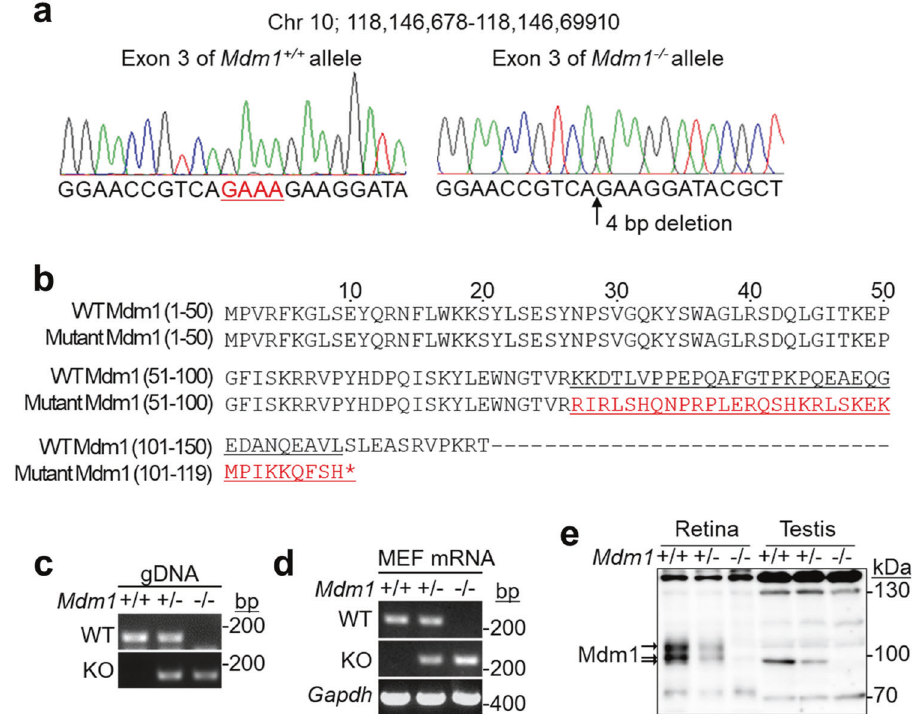
Fig. 1 Generation of Mdm1 − / − mice using a CRISPR/Cas9 system. a The DNA sequences of Mdm1 + / + and Mdm1 − / − alleles in Mdm1 exon 3. The deletion of 4 bp was con fi rmed in the Mdm1 − / − alleles. b The putative amino acid sequences of wild-type and mutant Mdm1 proteins. c The genotyping of Mdm1 + / + , Mdm1 + / − , and Mdm1 − / − mice. d The RT-PCR analysis of Mdm1 expression in Mdm1 + / + , Mdm1 + / − , and Mdm1 − / − MEFs. Gapdh expression was used as a loading control for cDNA. e The expression levels of Mdm1 protein in the retinas and the testes of Mdm1 + / + , Mdm1 + / − , and Mdm1 − / − mice as con fi rmed by Western blotting. gDNA, genomic DNA; MEFs, mouse embryonic fi broblasts; WT, wild-type; KO,